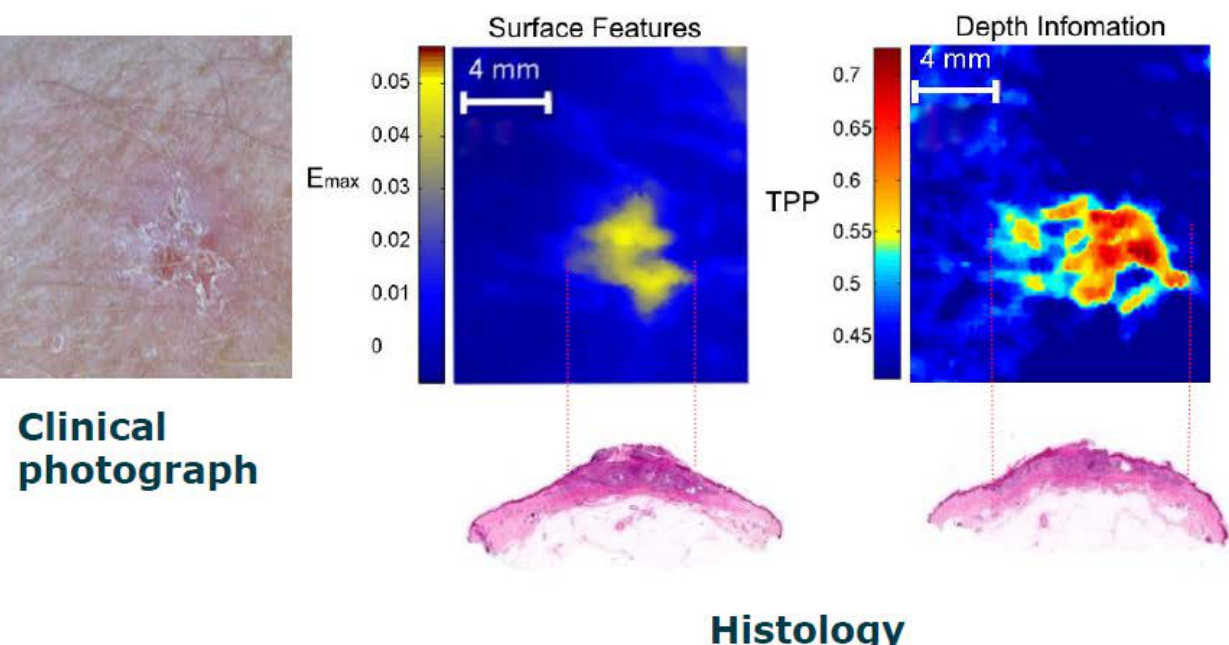
Figure 1. The above figure, (courtesy of TeraView), illustrates how basal cell carcinoma extends below the surface of skin in a patient. The left shows a photograph of the surface of the skin, a terahertz image of the surface is in the centre and the terahertz image of the stratum corneum–epidermis interface (not visible to the naked eye) shows that the cancer is widespread. See also reference [31].